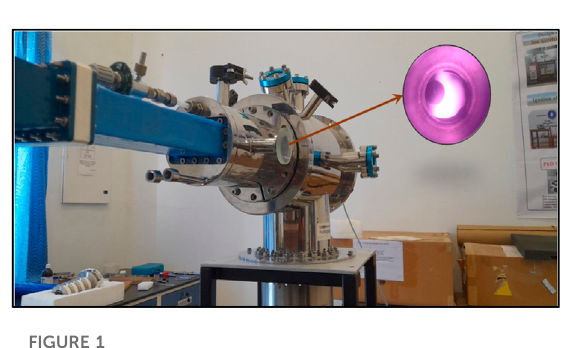
FIGURE 1 A close view of the 2.45 GHz microwave plasma treatment facility in the absence of permanent magnetic